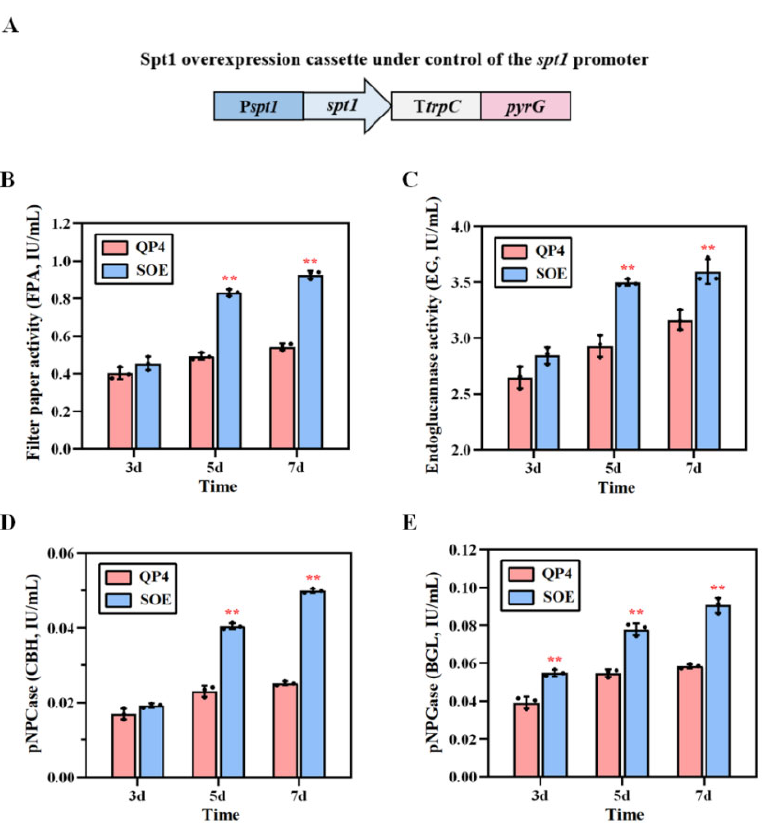
Figure 6. Cellulase production by the strain SOE, using the native promoter P spt1 to drive spt1 overexpression. ( A ) Schematic diagram of the spt1 gene overexpression cassette (6.0 kb) under the control of the native promoter P spt1 . The cassette would be inserted into the genome of T. reesei with multiple copies by random integration. The filter paper activity ( B ), the endoglucanase (EG) activity ( C ), the cellobiohydrolase (CBH) activity ( D ) and the β -glucosidase (BGL) activity ( E ) were measured at 3 d, 5 d, and 7 d of cellulase-inducing cultivation. The strains were cultured in cellulase-inducing medium containing MCC as the carbon source at 30 ◦ C for 7 days. The values represent the mean of three repeated measurements taken from at least three parallel experiments. The error bars refer strain was shown by the analysis of ANOVA, followed by the Turkey test. ** p <